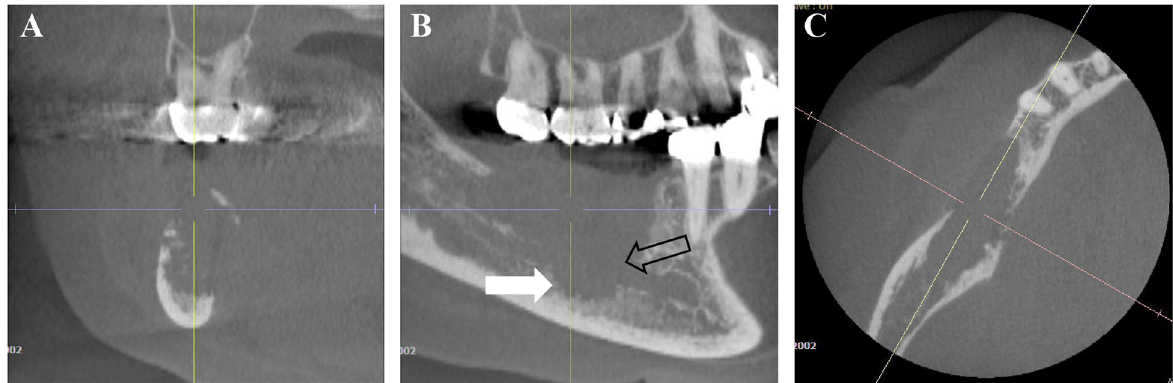
Fig. 3 Preoperative CT images and cone beam computed tomography (CBCT). Coronal ( a ), axial ( b ), and sagittal ( c ) cone-beam computed tomographic images show multilocular cortical expansion (arrows) and the indistinct mandibular canal (open arrows)